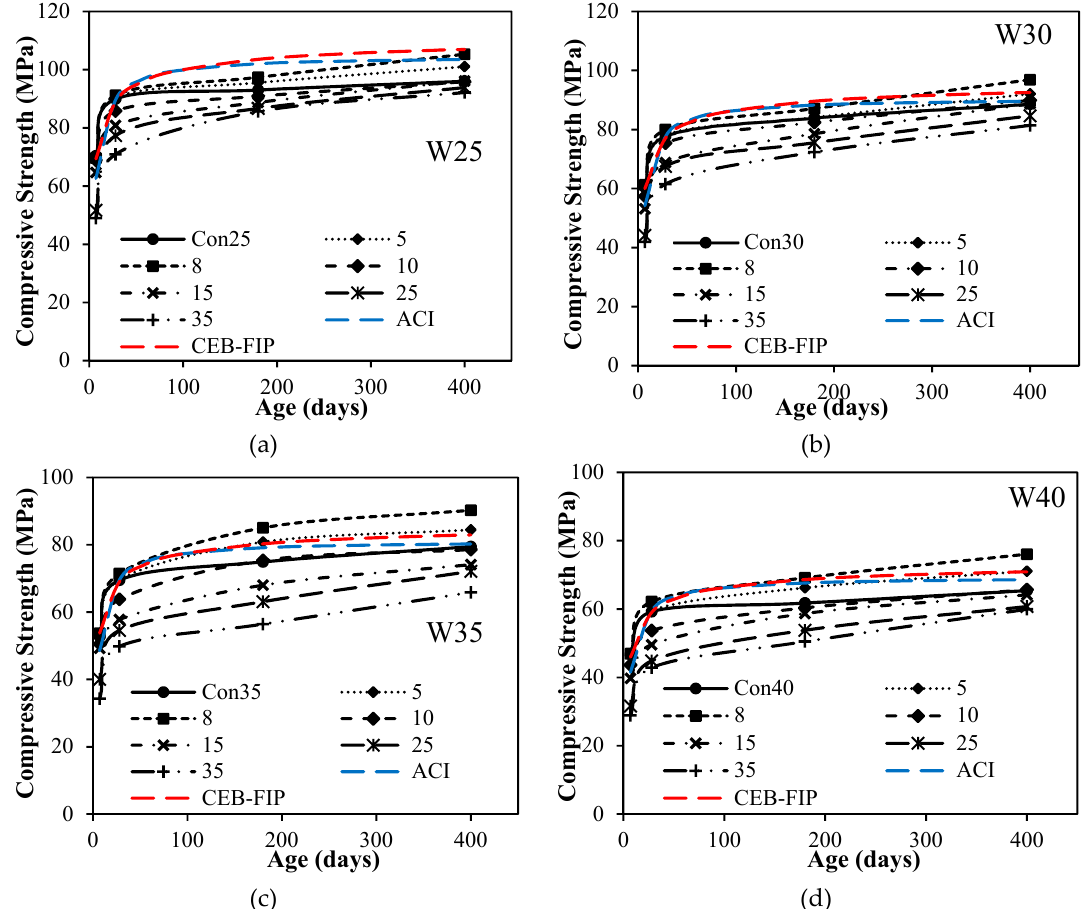
Figure 5. Compressive strength vs. age for different ultrafine dosages with different w/c ratios: ( a ) compressive strength vs. age for different ultrafine dosages at w/c 0.25; ( b ) compressive strength vs. age for different ultrafine dosages at w/c 0.30; ( c ) compressive strength vs. age for different ultrafine dosages at w/c 0.35; ( d ) compressive strength vs. age for different ultrafine dosages at w/c 0.40.